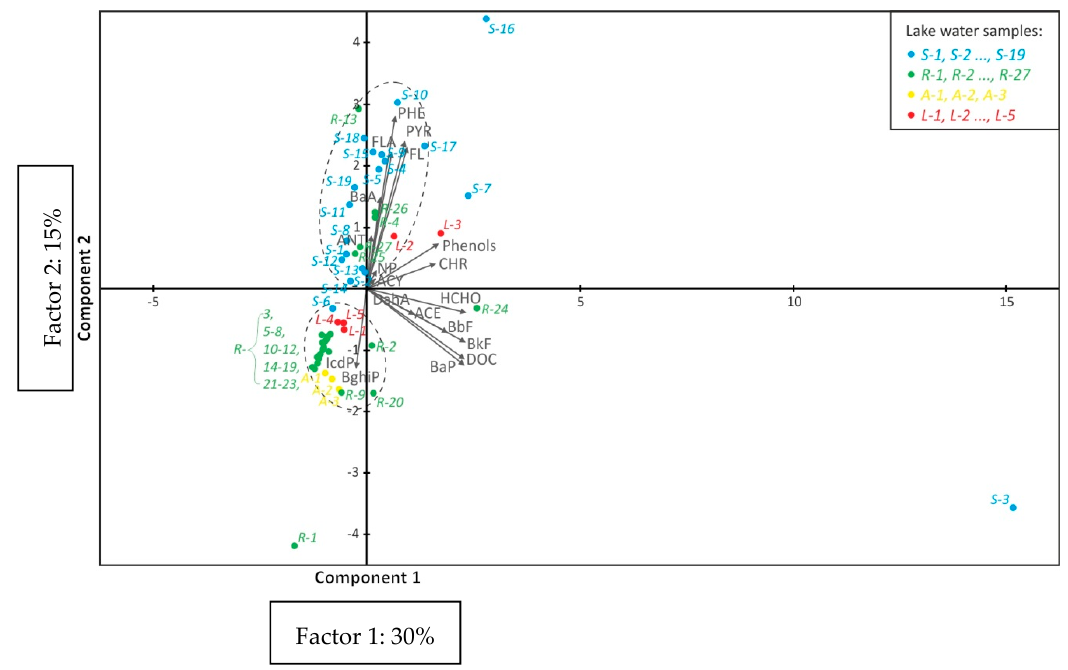
Figure 4. Variables and location of vectors in relation to principle components (F1 and F2). Lake water samples from Logne Valley (red dots), Scott Glacier (blue dots), Renard Glacier (green dots), Antonia Glacier (yellow dots).